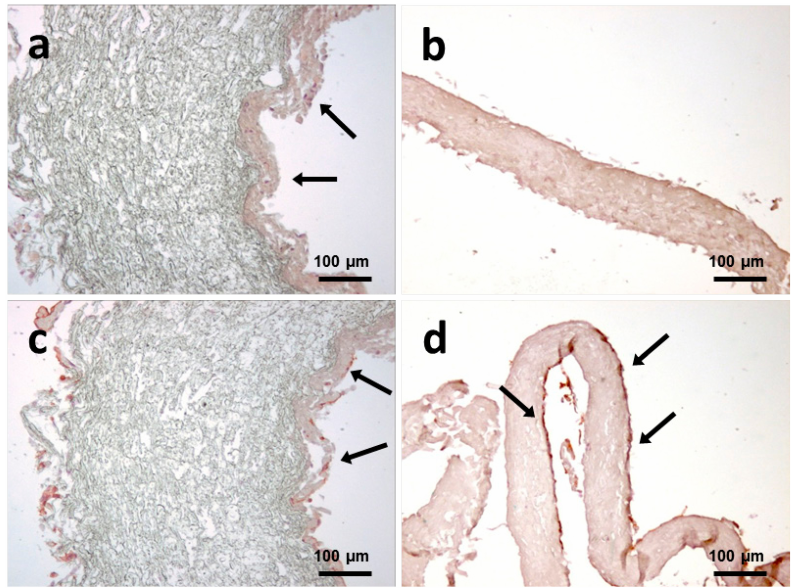
Figure 12. Immunohistochemical (IHC) analysis of dynamically seeded PU and collagen after EC-specific CD31 ( a + b , red) and FB-specific TE-7 ( c + d , red) staining. Positively stained cells are highlighted with arrows. Cell nuclei were stained with hemalaun. These are representative images of an experiment in triplicates.